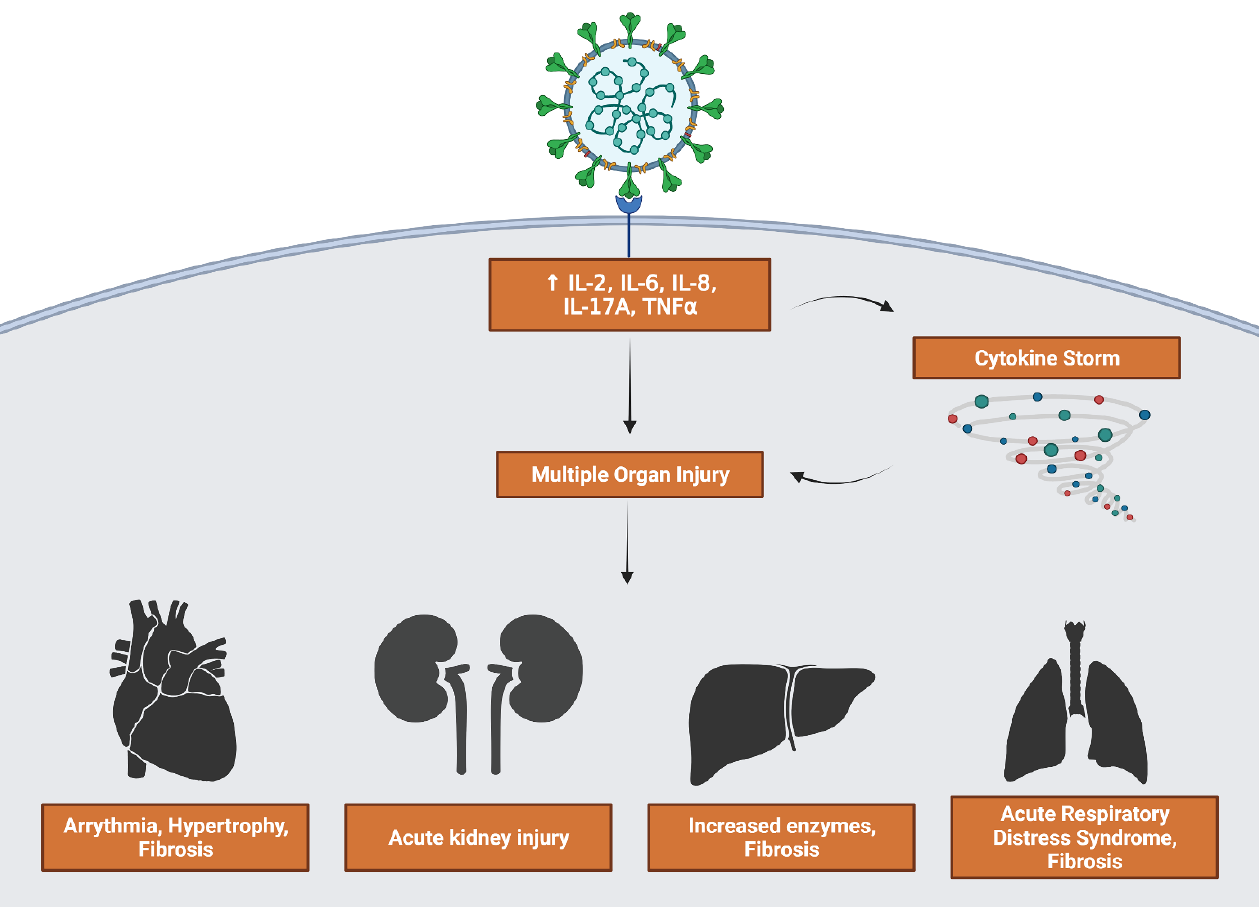
Figure 7. Consequences of viral stimulation of inflammatory factors. Upregulation of cytokines feeds directly into multiple organ injury as well as activating a cytokine storm that further contributes to injury. Generated in Biorender. IL-2 is a cytokine that is a part of the immune response to infection. It mostly activates leukocytes via IL-2 receptors on their cell surface, stimulating inflammation to combat the